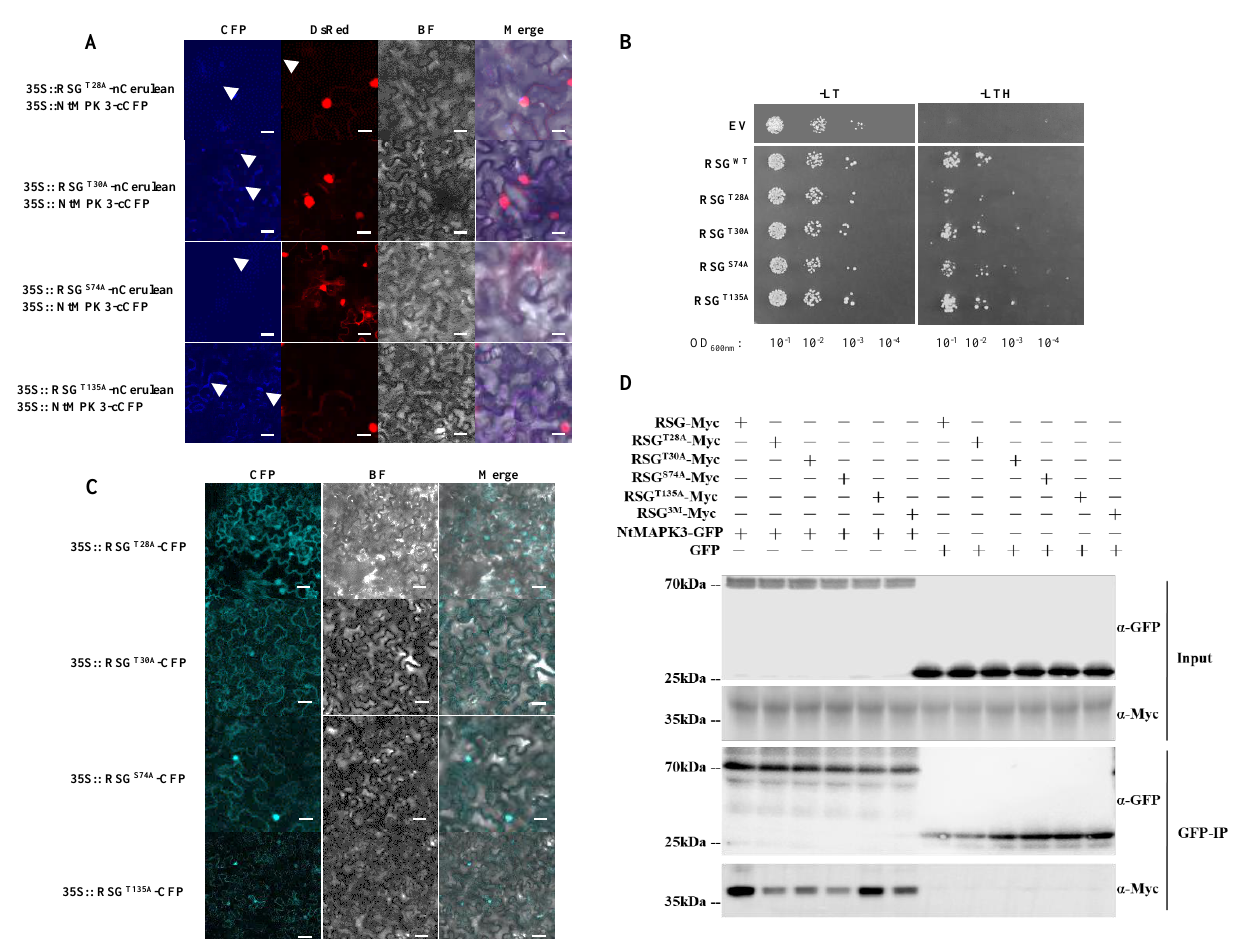
Figure 4. Interaction between NtMPK3 and four amino acid mutants of NtRSG and their localization in tobacco cells by BiFC. ( A ) BiFC assay. RSG-nCerulean or RSG-derived single-point amino acid mutants fused with nCerulean and NtMPK3-cCFP were co-expressed in N. benthamiana . NLS- VirD2 fused with DsRed refer to the localization of nuclear. Scale bars = 20 µ m. ( B ) Yeast-two-hybrid interaction assay. LexA-NtMPK3(KIM Domain) was co-expressed with Gal4-AD fused to RSG or RSG site mutants. The indicated dilutions of cell cultures were plated and grown on non-selective (+histidine) and selective media ( − histidine). ( C ) RSG and indicated mutants tagged with CFP were transiently expressed in agroinfiltrated leaf epidermis of N. benthamiana and analyzed by confocal microscopy three days post-infiltration. CFP signal is in cyan. Images are single confocal sections, representative of images obtained in two independent experiments performed for each protein; for each experiment, three infiltrations were performed on three different leaves, with two images recorded per infiltration. Scale bars = 40 µ M. ( D ) Co-immunoprecipitation interaction assay. NtMAPK3-GFP was expressed with C-terminus Myc-tagged RSG and its relative mutants for 3 days in agroinfiltrated Nicotiana benthamiana leaves and immunoprecipitated (IP) with anti-GFP antibody (top panel), followed by Western blot analysis with anti-GFP or anti-Myc antibody. Two independent experiments were performed for each assay with similar results.